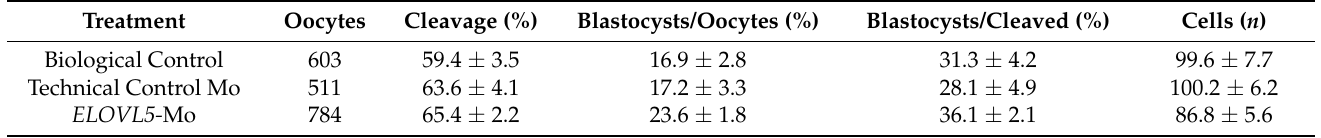
Table 2. Effect of the elongation of very long chain fatty acid enzyme 5 (ELOVL5) gene knockdown assay on the development and the total number of embryonic cells (mean ± standard error).